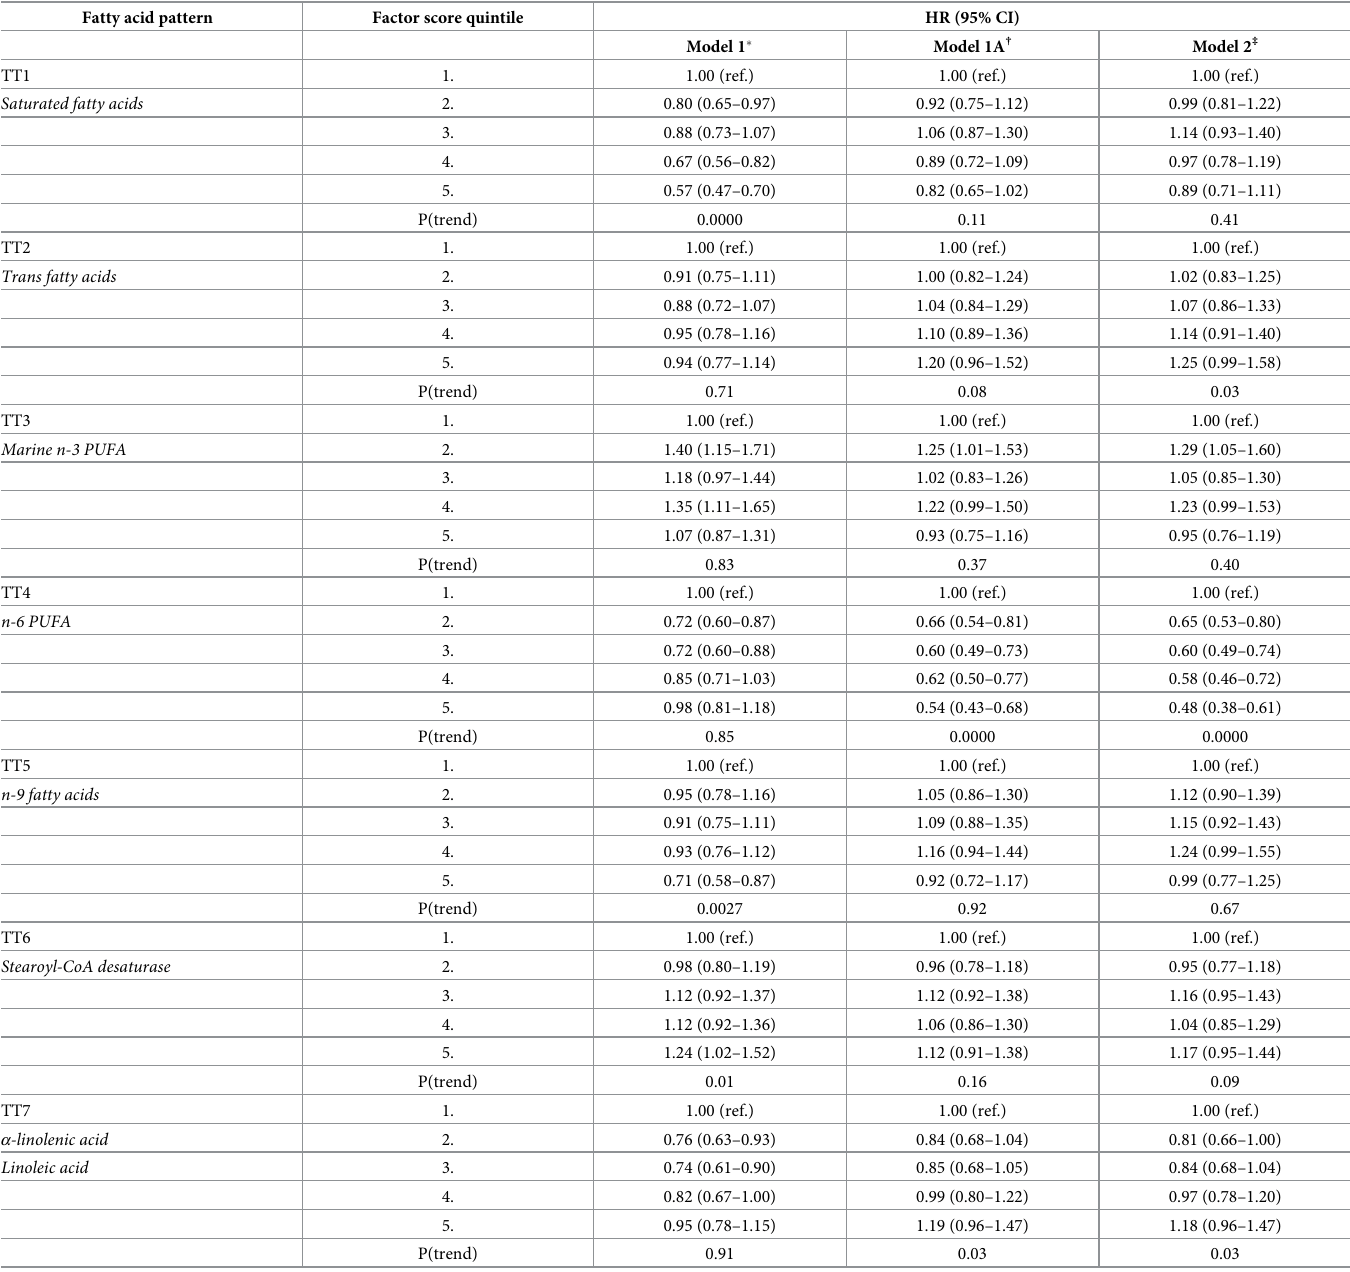
Table 3. Results for